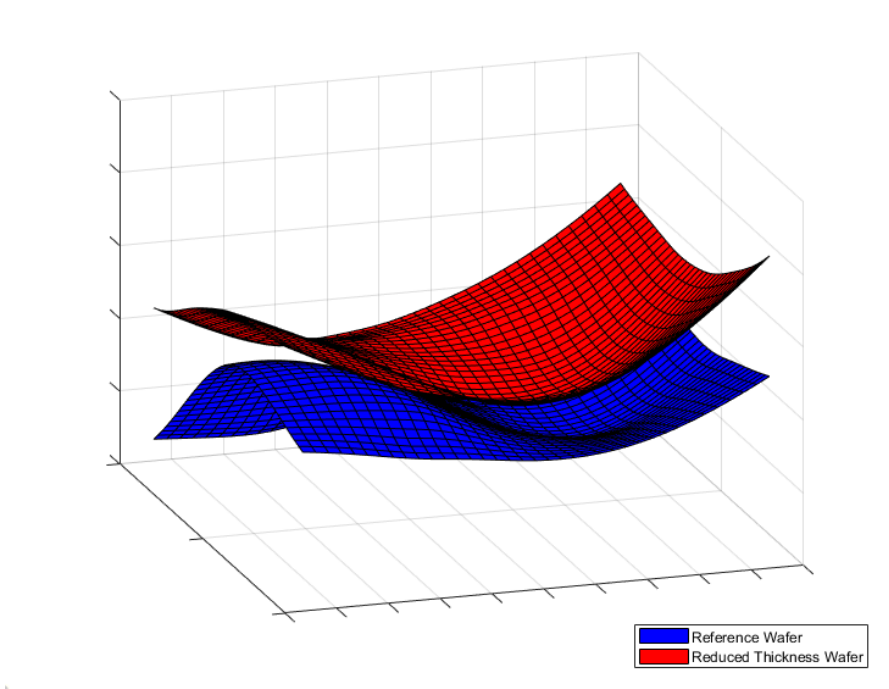
Figure 13. Overall shape comparison for reference and reduced